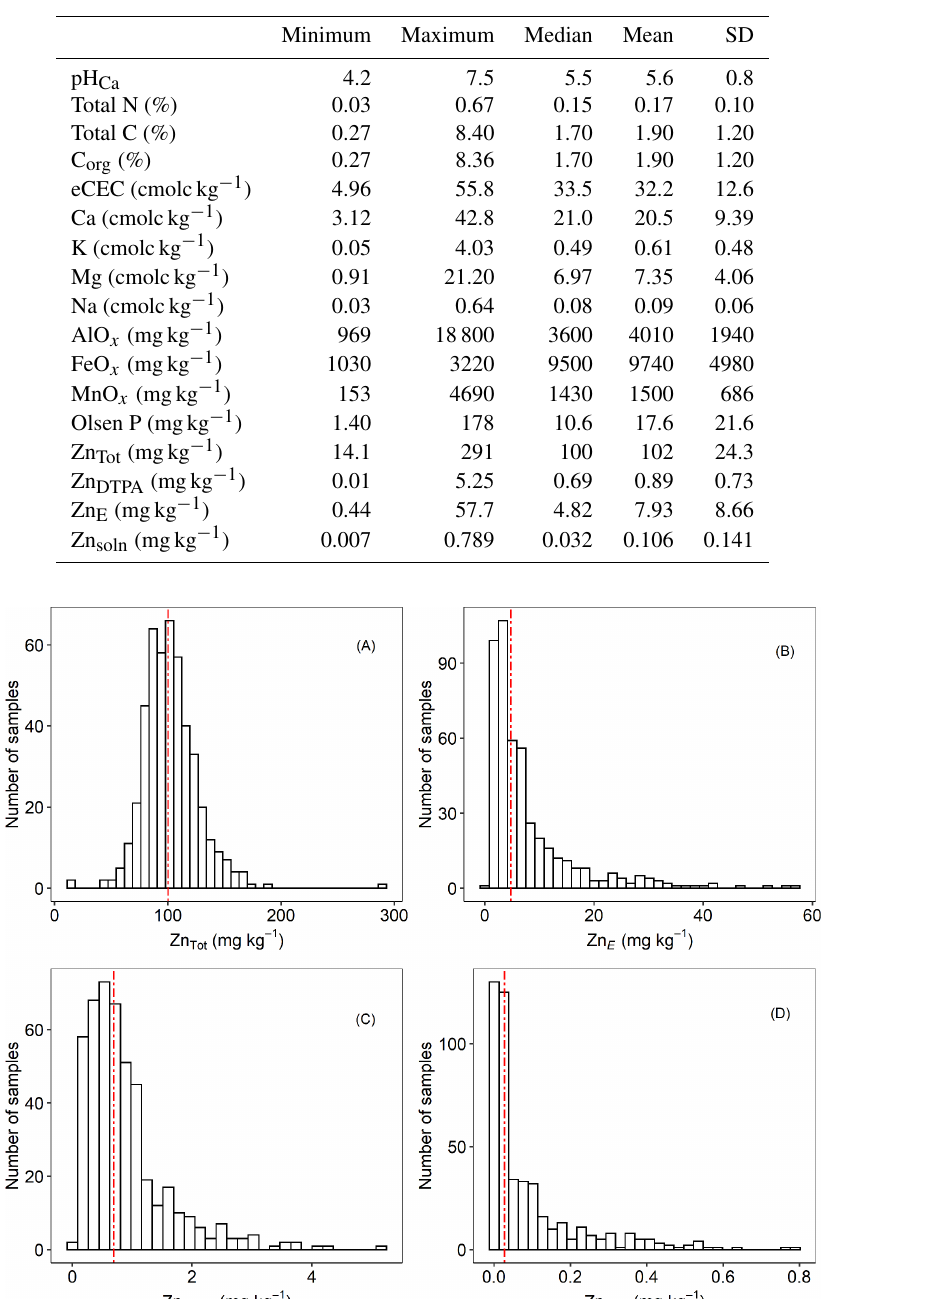
Table 1. Selected properties for soil samples ( n = 465). Note: SD is the standard deviation.